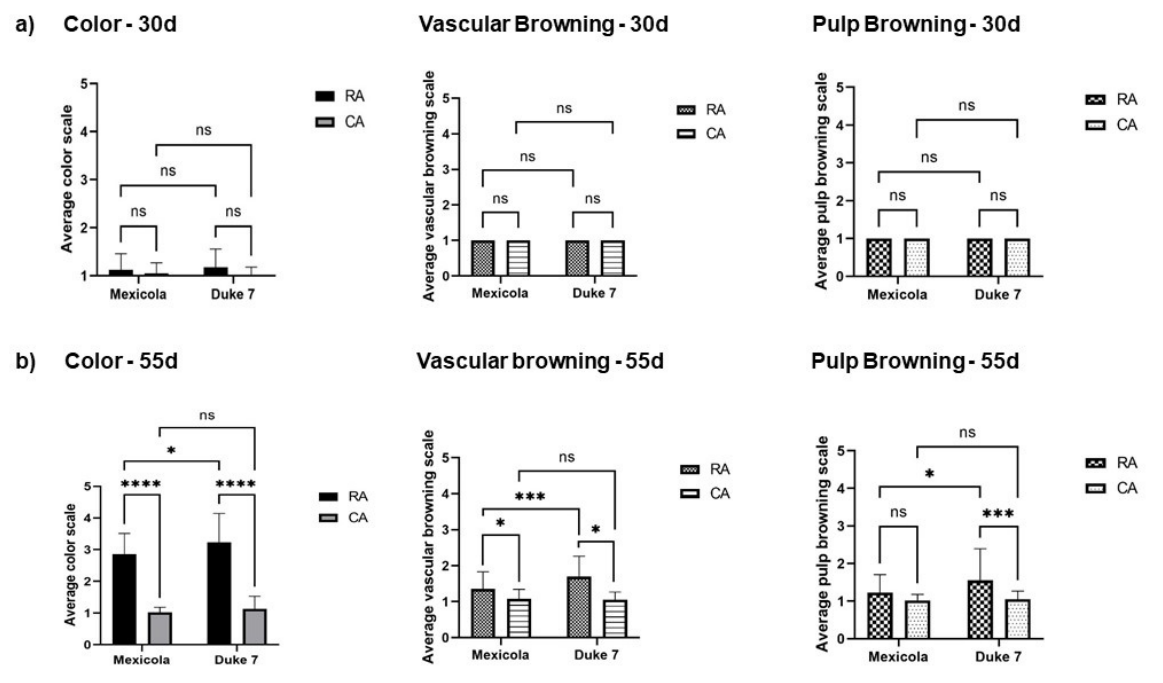
Figure 2. ( a , b ) Color and vascular and pulp browning for Hass avocado fruit from “Mexicola” and “Duke 7” rootstocks stored up to 30 d ( a ) and 55 d ( b ) in regular air (RA, 5 °C) and controlled at- mosphere (CA, 4 kPa O 2 and 6 kPa CO 2 at 5 °C). A two-way ANOVA was performed, considering rootstock and storage conditions as factors. Significant differences are represented with an asterisk (*, p -value < 0.05; ***, p -value < 0.001; ****, p -value < 0.0001; ns, not significant).